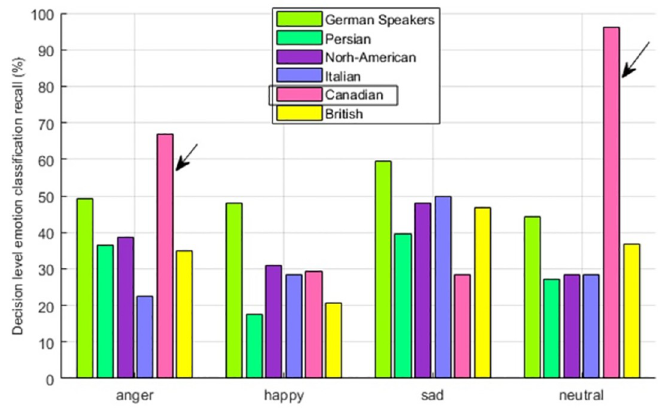
Fig 6. Canadian speaker—Multicultural emotion recall comparison and In-group